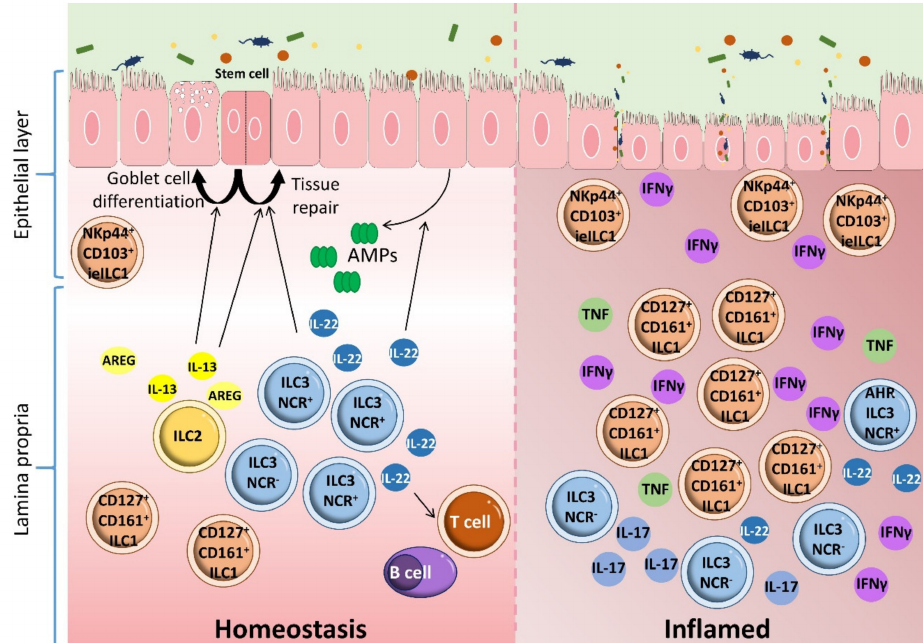
Figure 5. ILCs, homeostasis, and inflammatory bowel disease. There are two major subpopulations of ILC1s in the human gut: lamina propria ILC1s (CD161 + CD127 + ) and intraepithelial ILC1s (NKp44 + CD103 + CD127 − ). ILC2s are present in lower numbers than ILC1s and ILC3s. ILC2s contribute to epithelial barrier maintenance through the production of IL-13, which promotes the differentiation of intestinal epithelial stem cells toward turf cells and goblet cells. ILC2s also maintain intestinal epithelia homeostasis through the production of amphiregulin (AREG). ILC3s maintain gastrointestinal tract homeostasis by producing IL-22. This cytokine activates intestinal epithelial cells to produce antimicrobial peptides, enhances the renewal of epithelial cells, promotes tissue repair and modulates the homeostasis of adaptive immunity. Alteration of the ILC subset profile disturbs intestinal homeostasis and leads to inflammation in the gut. ILC3s and ILC1s are involved in the induction of inflammation and are closely related to IBD pathogenesis. This conclusion is supported by the amplification of intraepithelial IFN- γ -producing ILC1s in response to IL-12 and IL-15 in the gut of CD patients. This increase is accompanied by a reduction in NCR + ILC3s, enhancing disease